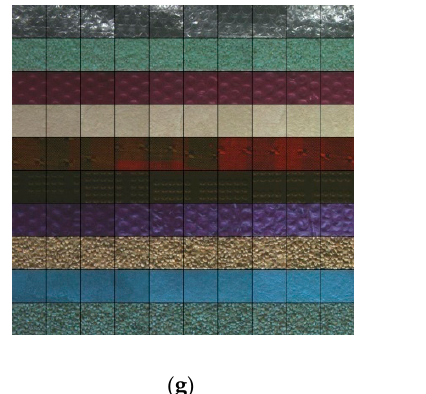
Table 2. The highest average precision rate (APR) values of LPCP, RILPCP, and uniform local parallel cross pattern (ULPCP) with the optimal color quantization layers ( W a* , W b* ) on the eight databases.